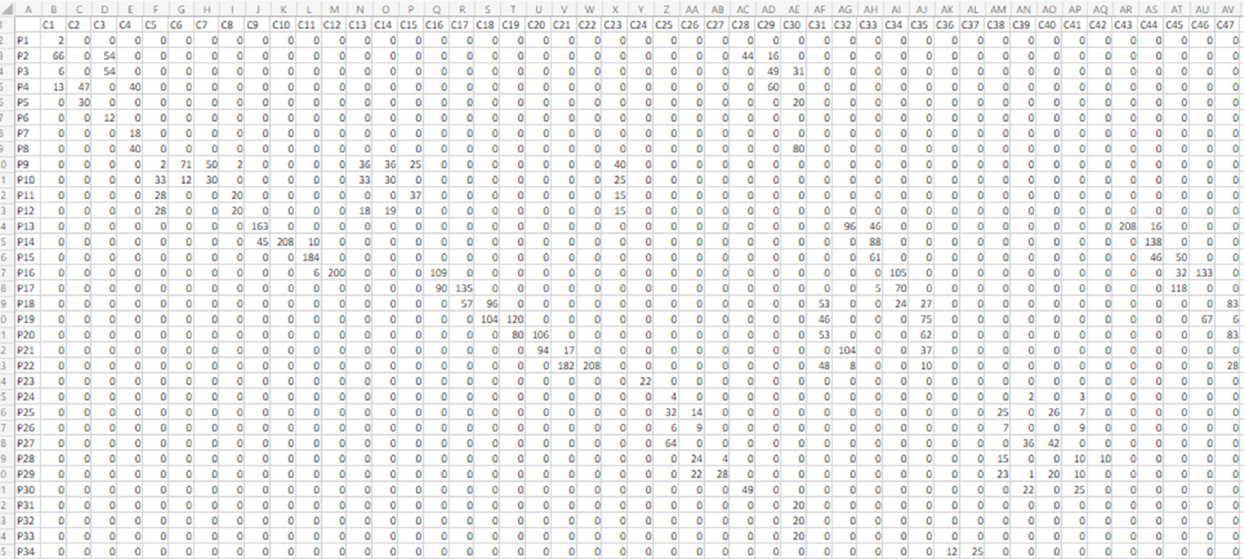
Figure 6. Quantity of products inside containers, Case 2, in the form of an Excel spreadsheet.